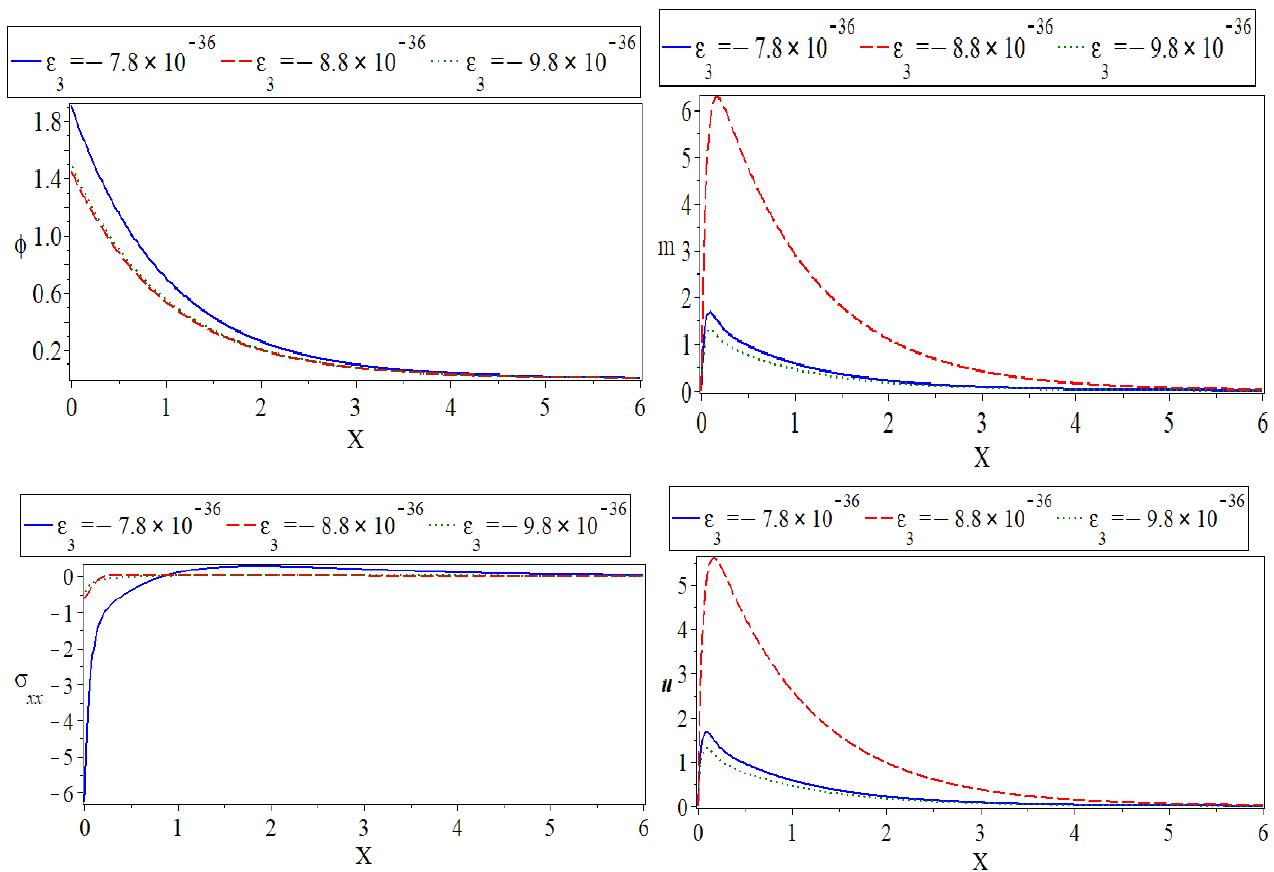
Figure 1. Represents the variations of main fields in this phenomenon according to the different values of two-temperature parameter under the effect of moisture Figure 2. The variation of physical field distributions with distance at different values of thermoe- Figure 2. The variation of physical field distributions with distance at different values of thermoelec- values of two-temperature parameter under the effect of moisture field. ε tric coupling parameter ε 3 under the effect of moisture and ε 1 = 0.001. under the effect of moisture and lectric coupling parameter 3